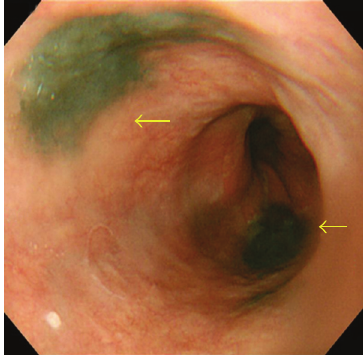
Figure 1: Esophagoscopy showing several flat and black pigmented mucosal lesions in the distal esophagus and esophagogastric junction (arrows).